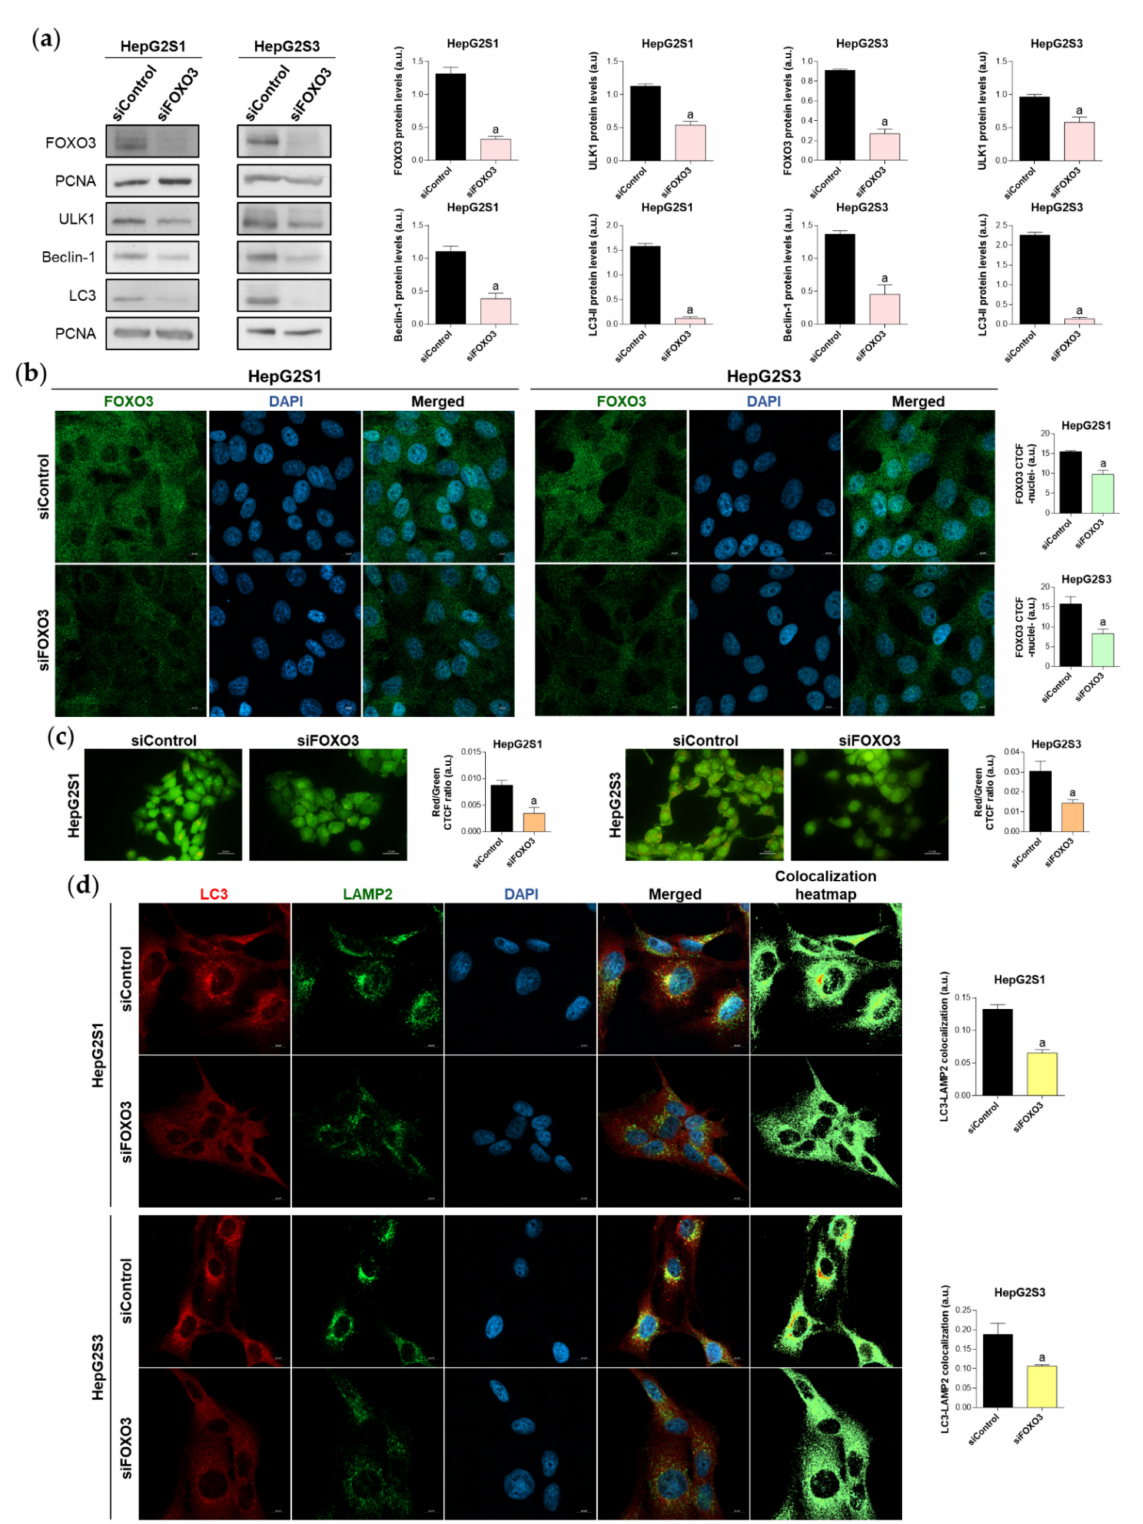
Figure 4. Effect of FOXO3 knockdown on the basal autophagic status of HepG2S1 and HepG2S3 sorafenib-resistant cell lines. All the assays were carried out at 48 h post-silencing. ( a ) Immunoblots of FOXO3 and several autophagy targets. Densitometry reading of each band is shown; ( b ) Analysis of FOXO3 nuclear translocation by confocal microscopy and FOXO3 immunofluorescence. Green fluorescence, FOXO3. Blue, cell nucleus. Magnification 63 × , scale bar 10 µ